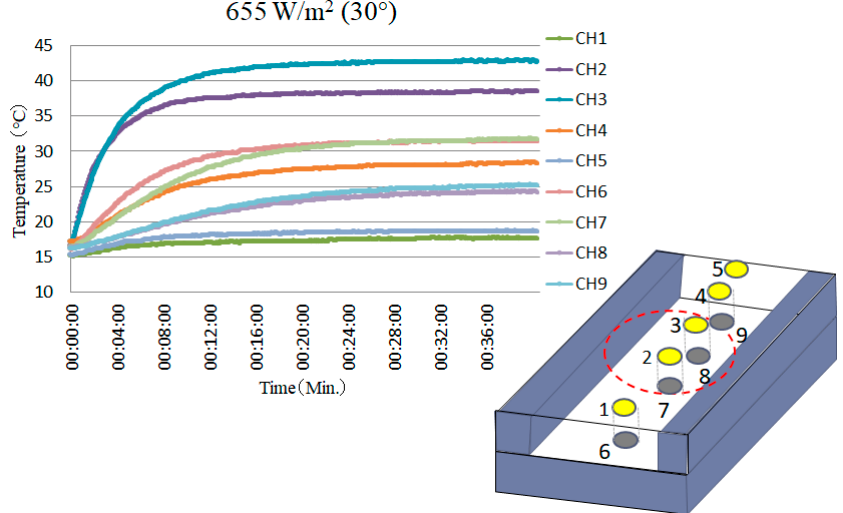
Figure 12. Temperature profiles in small-scale OPV-solar chimney as a function of time. Dashed circle indicates light-exposed area.